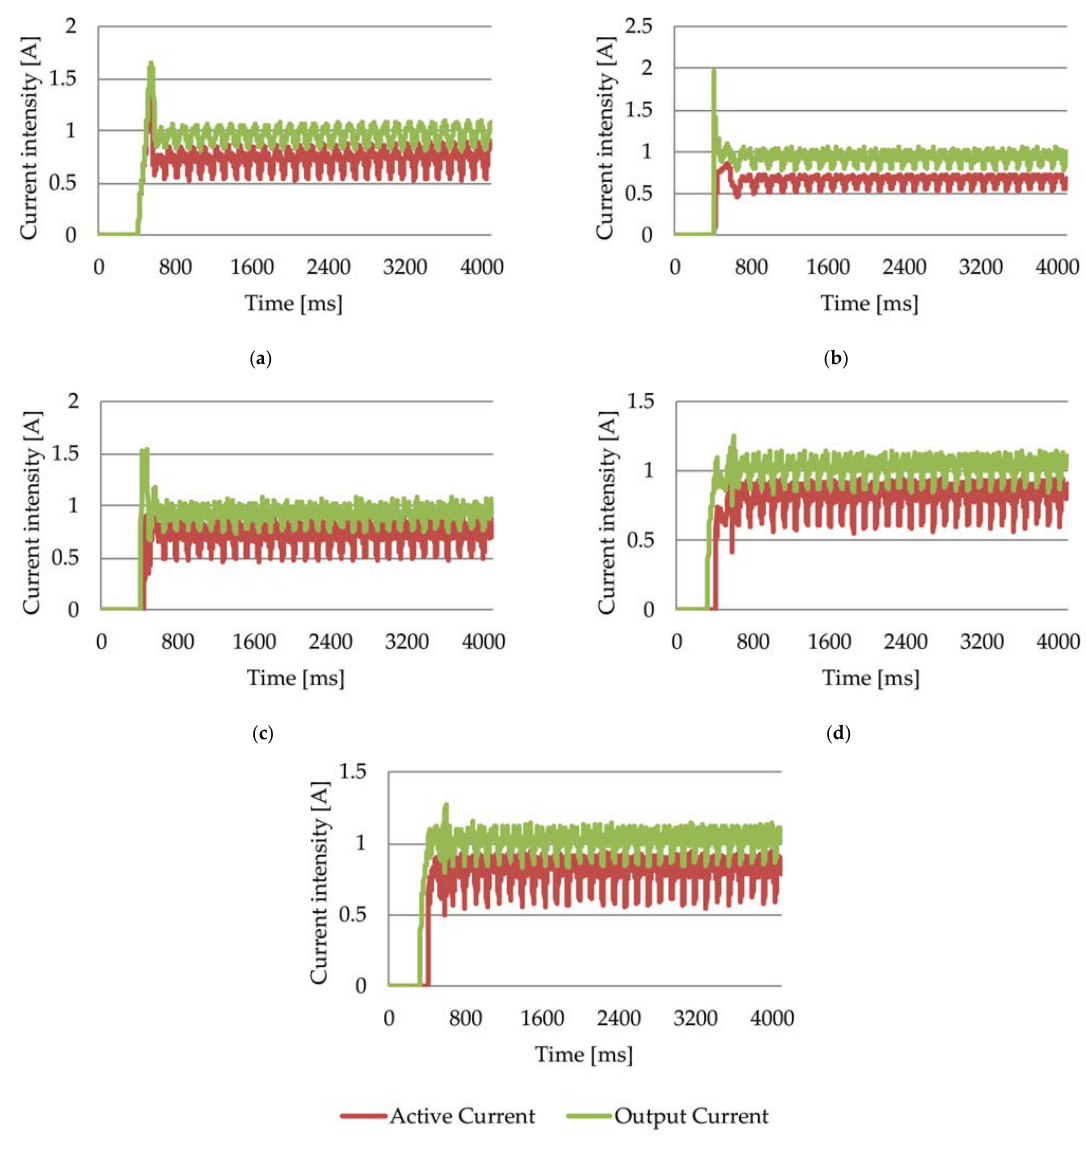
Figure 7. Characteristics of the output current intensity (I O ) and the active current intensity (I A ) in various control modes (with the external load): ( a ) V/f, ( b ) VFC without an encoder, ( c ) VFC n-control, ( d ) CFC, ( e ) CFC with torque control. Figure 8 shows a comparison of the load state currents for various control modes. There is a characteristic current peak visible in the scalar mode due to its lack of precision in the control over the motor dynamics.